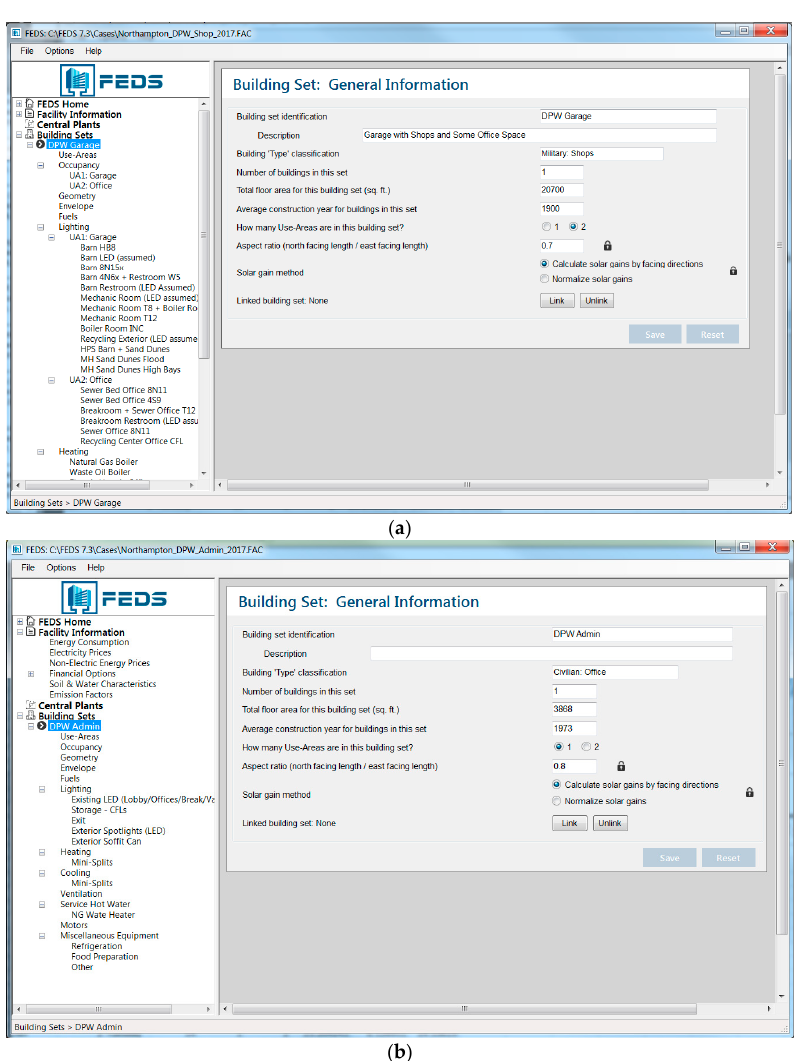
Figure 6. FEDS screen shots show the DPW garage ( a ) and administrative building ( b ) models. Created via the FEDS software [17].